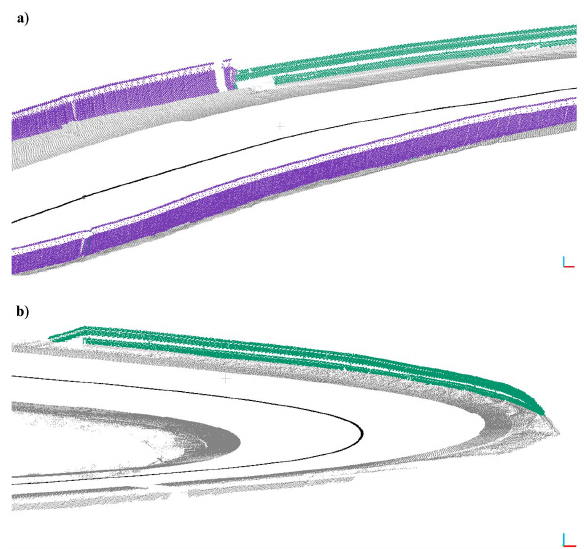
Figure 6. Concrete barriers highlighted in violet, and double guardrails visualized in